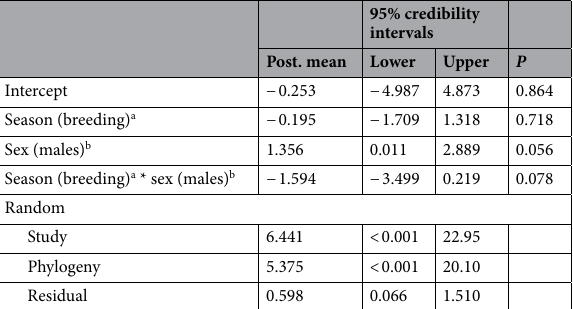
Table 3. White blood cell levels and immune response in wild birds in relation to sex and season (MCMC generalised linear mixed models; n , total number of individuals; s , number of species). p values < 0.05 in bold. a Relative to the non-breeding period. b Relative to